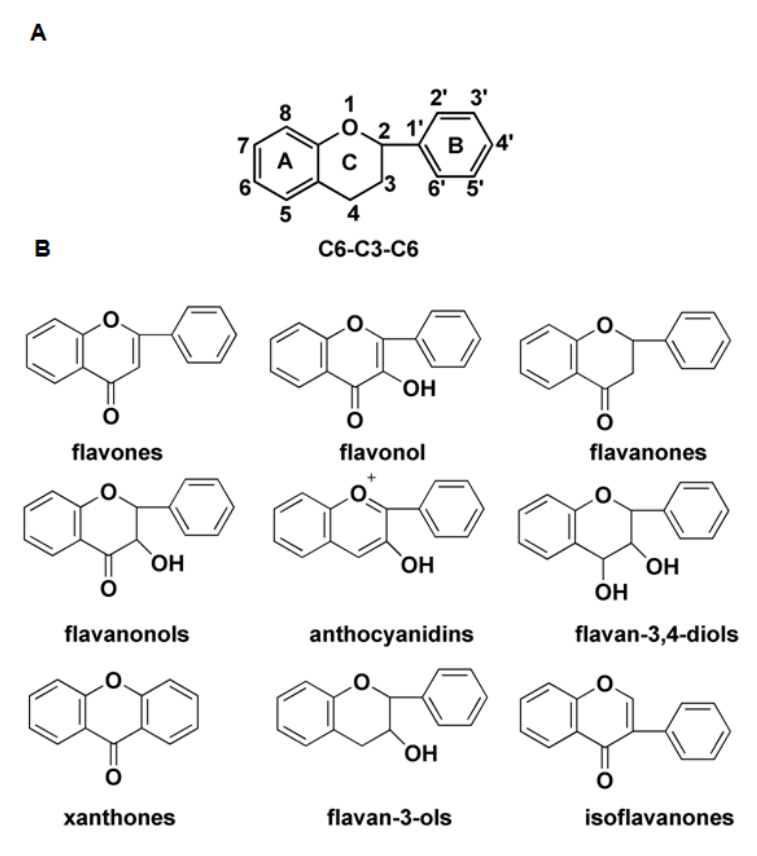
Figure 1. The structure of the flavonoids. ( A ) Flavan (C6–C3–C6) skeleton of flavonoids; ( B ) The oxidation status and saturation of the heterocyclic ring is used to classify the